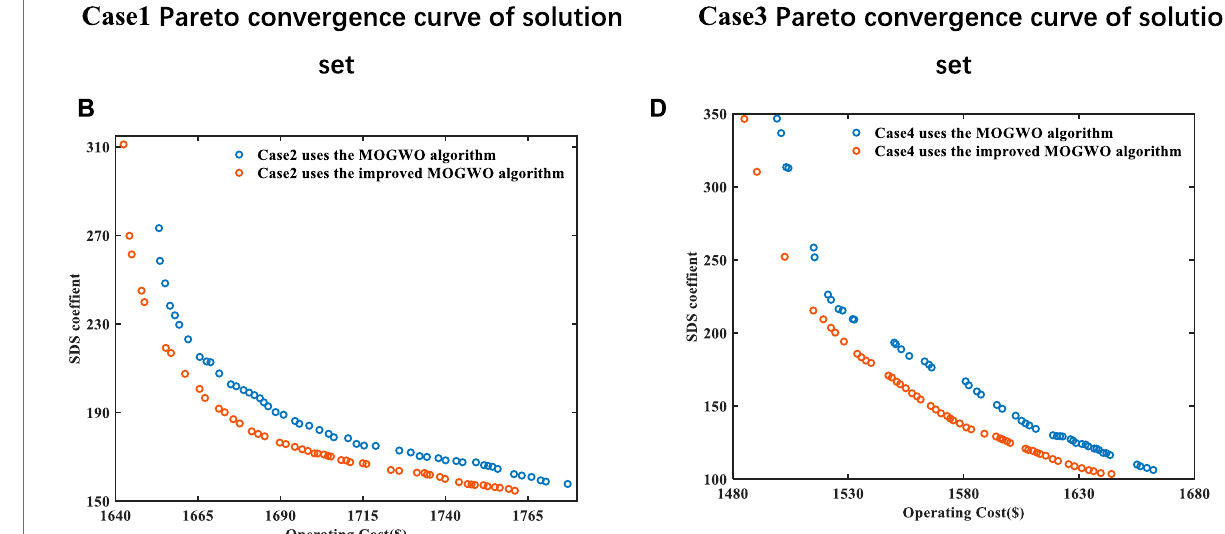
Frontiers in Energy Research |